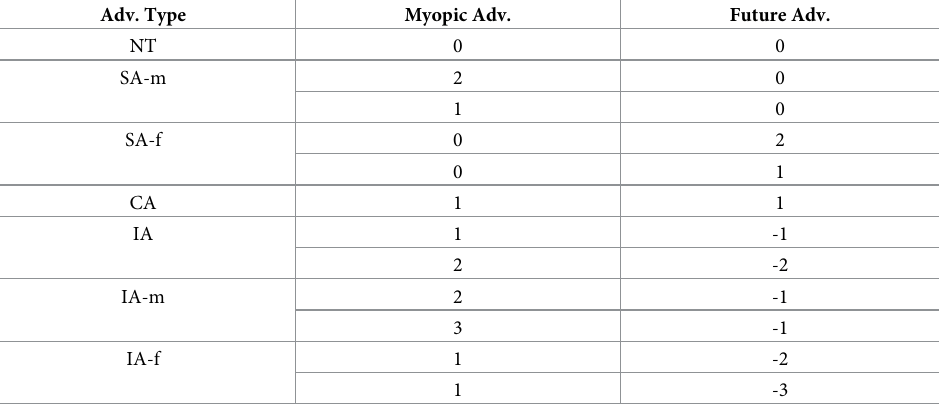
Table 1. Myopic and future path advantages. All trial layouts were mirrored except for the NT trial. NT = neutral advantage, SA = single advantage, CA = congruent advantage, IA = incongruent advantage. The -m and -f suffixes indi- cate whether the myopic or future advantage was